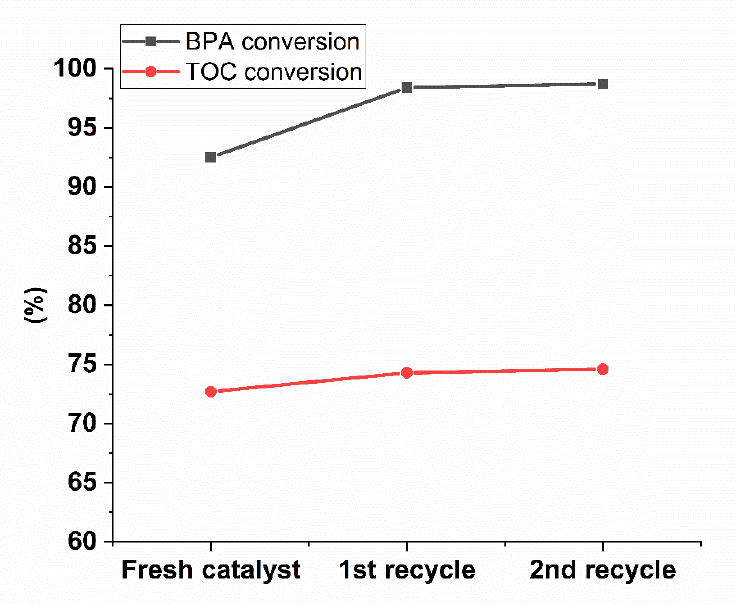
Figure 7. Recycling results for PSD/MK_Fe at reaction time 180 min. Operating conditions: p (air): 20 bar, c (BPA): 60 mg/L, c (catalyst): 1 g/L, T: 160 ◦ C, 800 rpm. RSD ± 3%. Note the y -axis